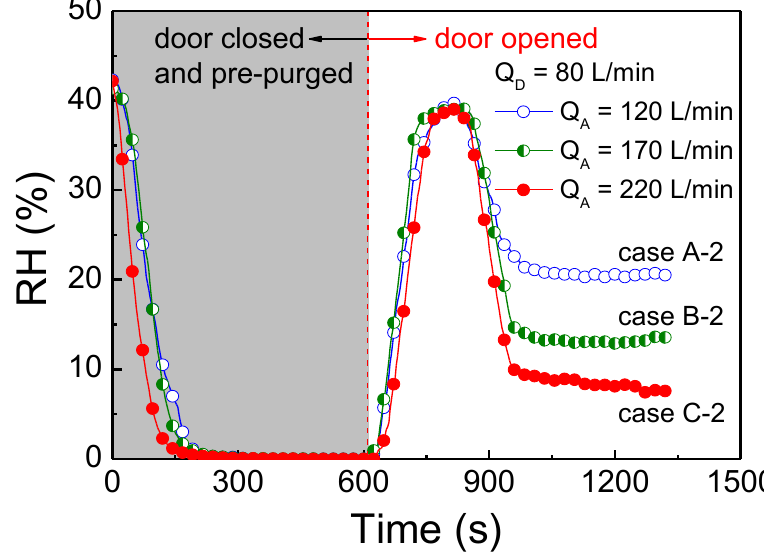
Figure 8. RH evolutions as function of CDA flow rate to air curtain at given CDA flow rate of 80 L/min to the diffuser-purge system.